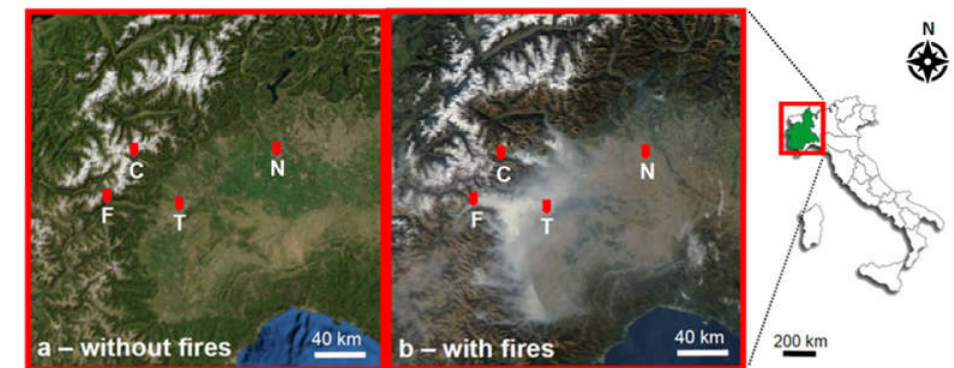
Figure 1. Geographical location of the monitoring stations. ( a ) Orthophotos, ( b ) Satellite image during wildland fires (25 October 2017) [24]. F = Chiomonte (wildland fire); T = Torino (high traffic); C = Ceresole Reale (rural); N = Novara (moderate